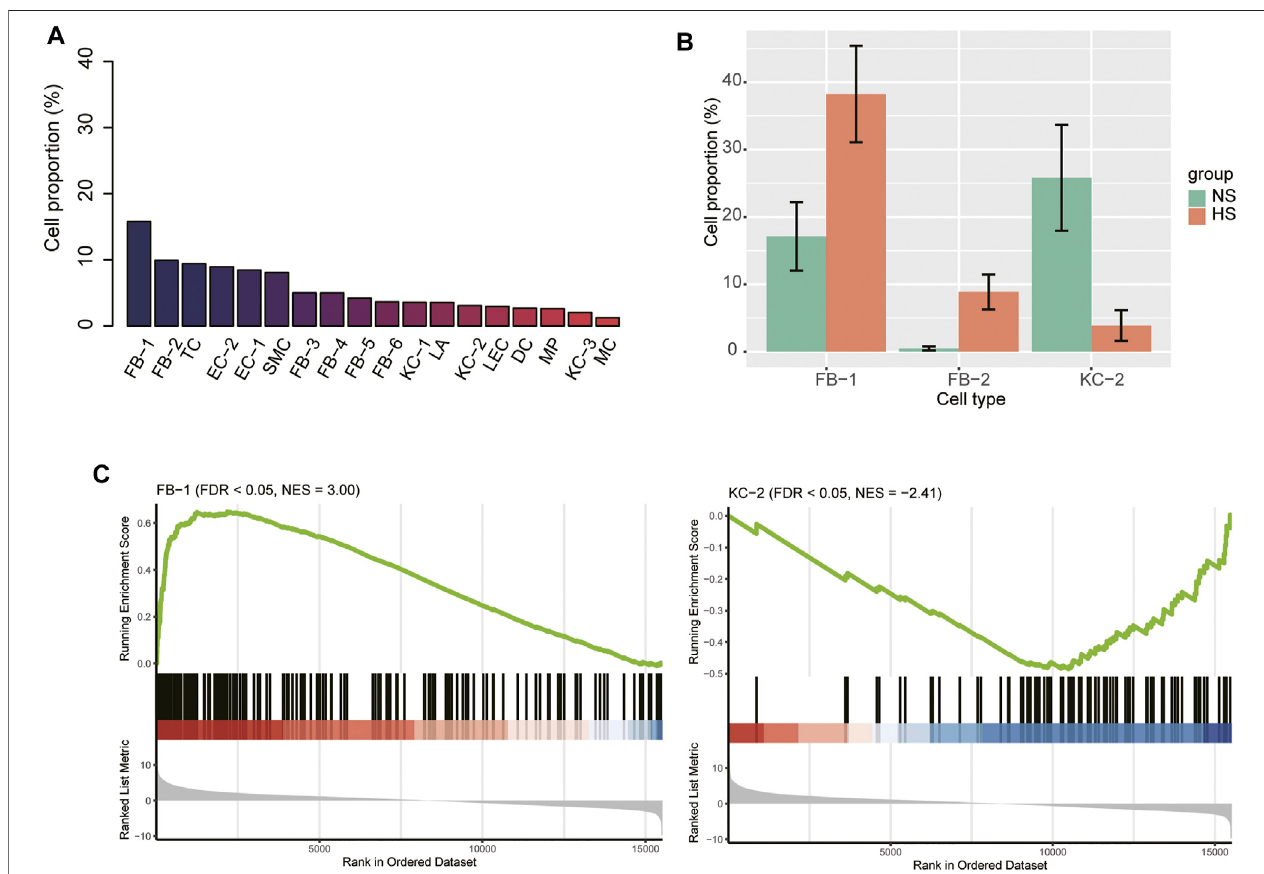
FIGURE 2 | The cell proportions within HS and normal skin samples. (A) The cell proportions within the integrated HS and normal skin samples. (B) The cell types with differential proportions between HS and normal skin. (C) The differential expression levels of the FB-1 and KC-2 speci fi c marker genes between the HS and normal skin